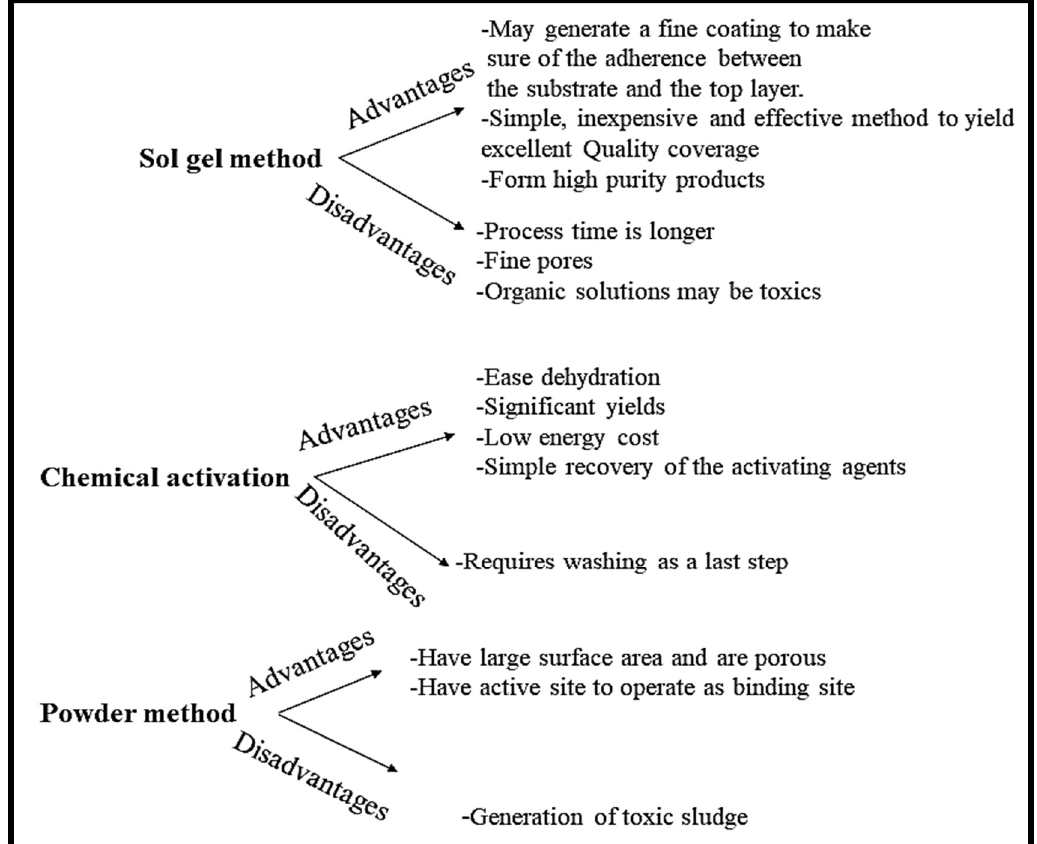
Figure 1. Advantages and drawbacks of powder, chemical activation, and sol gel methods [60–62].